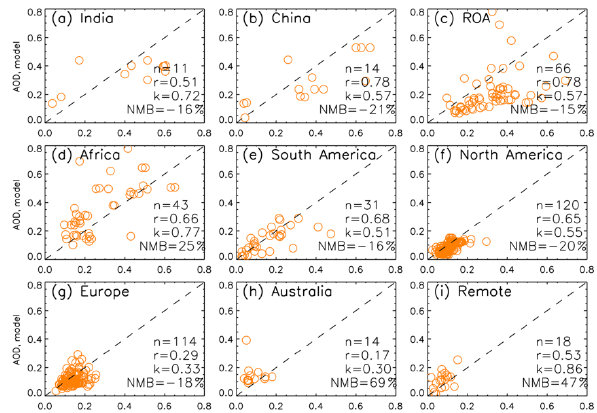
Figure 3. Scatter plots of AOD between model simulation and ob- servations over (a) India, (b) China, (c) rest of Asia (ROA), exclud- ing China and India, (d) Africa, (e) South America, (f) North Amer- ica, (g) Europe, (h) Australia and (i) remote regions. For each panel, the total number of observational sites ( n ), model–observation re- gression slopes ( k ), correlation coefficient ( r ) and NMB are in-